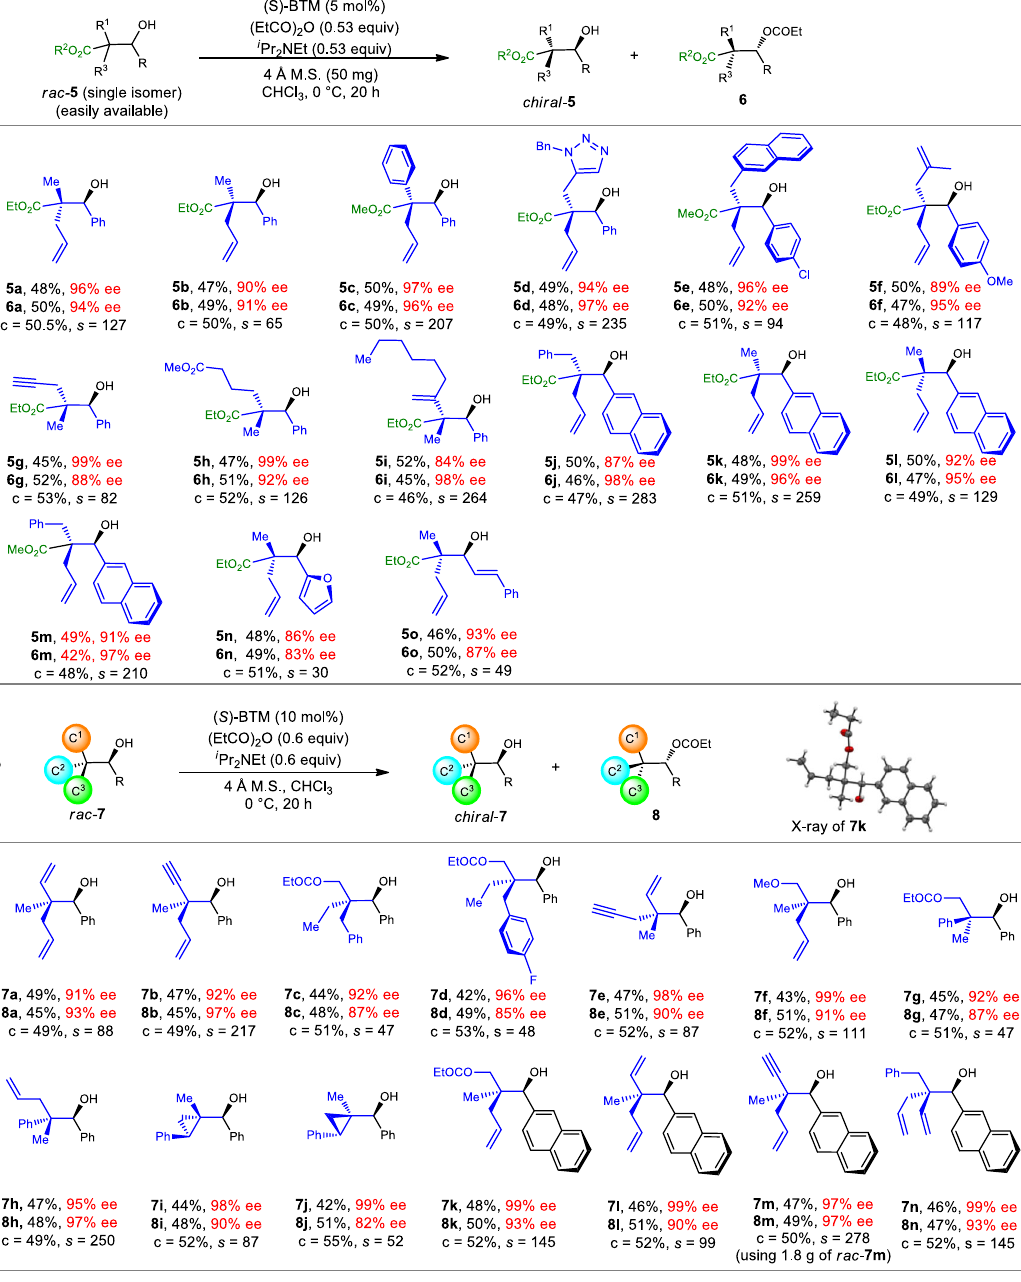
Fig. 4 Resolution of ester and methane derivatives bearing quaternary stereocenters. a Scope of esters with α -quaternary stereocenters. Variation of the standard conditions: 5f : 10 °C, 28 h; 5b / 5j / 5m : 20 °C; 5c / 5d : ( S )-BTM (10 mol%); 5g / 5i / 5l / 5n / 5o : ( S )-BTM (10 mol%), − 10 °C. b Scope of tetrasubstituted methane derivatives. Variations of the standard conditions: 7c / 7g : − 10 °C, 23 h; 7h : ( S )-BTM (15 mol%), − 20 °C, 40 h; 7i : ( S )-BTM (4 mol%), i Pr 2 NEt (1.0 equiv), toluene; 7j : i Pr 2 NEt (1.0 equiv), toluene, 12 h; 7k / 7m : ( S )-BTM (5 mol%). c